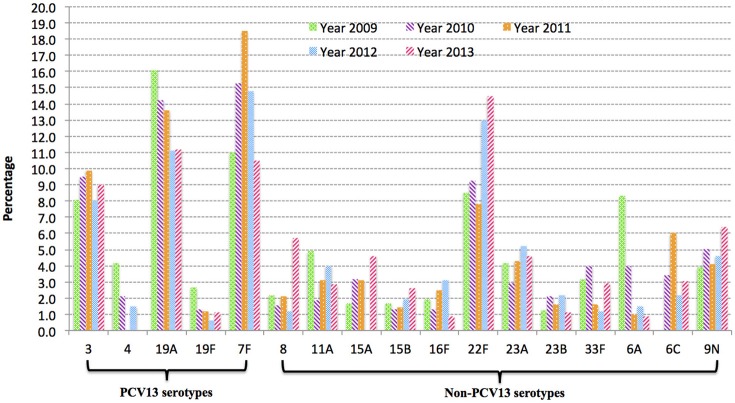
Serotype changes over time in IPD among older adults (≥50 years of age) in Ontario, Canada from 2009 to 2013. Serotype 22F increased significantly after introduction of PCV13 (p < 0.01) between 2009 and 2013, and became most prevalent in 2013.